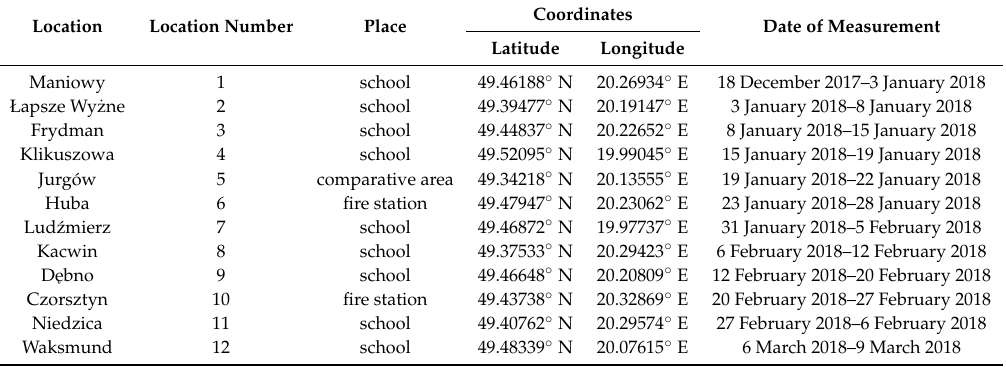
Table 1. Characteristics of air quality measurement points in the Niedzica recreational area. Location Location Number Place